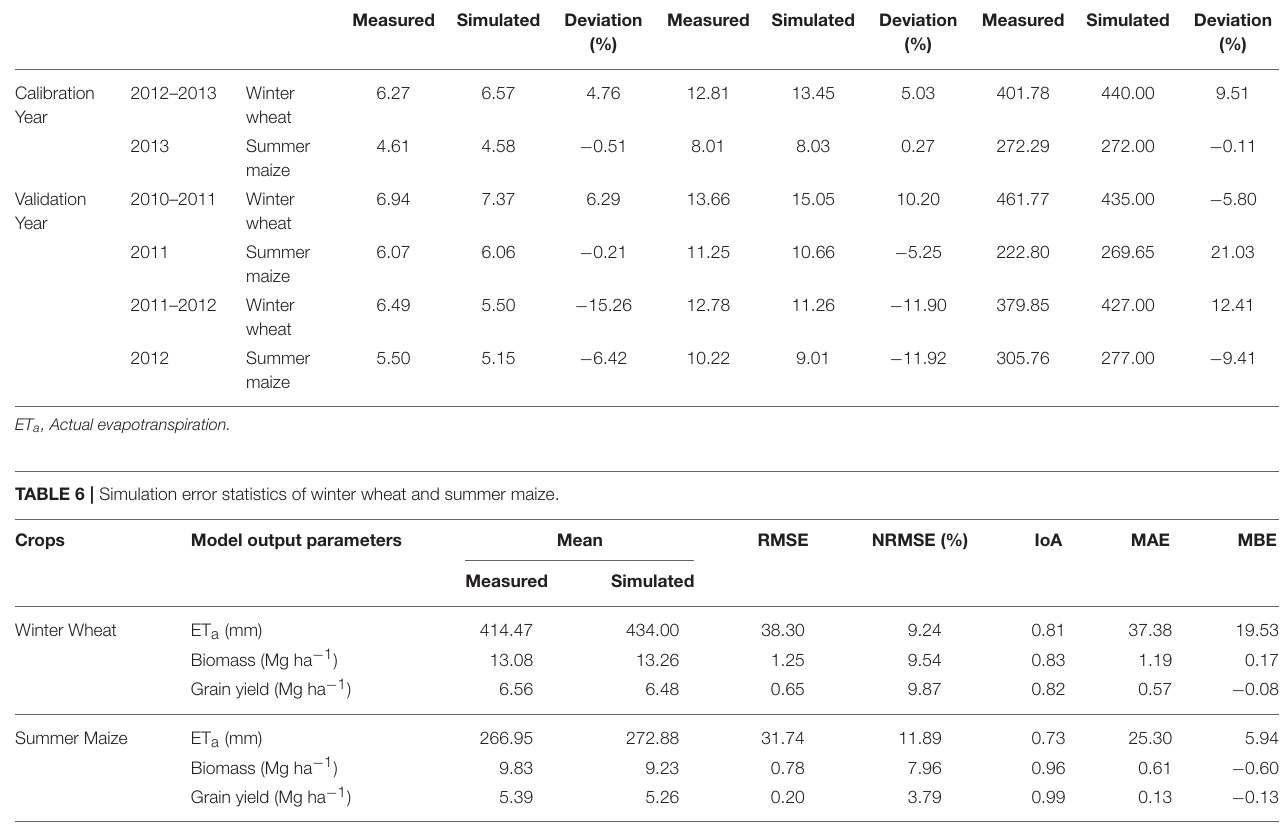
Measured Simulated Deviation (%)